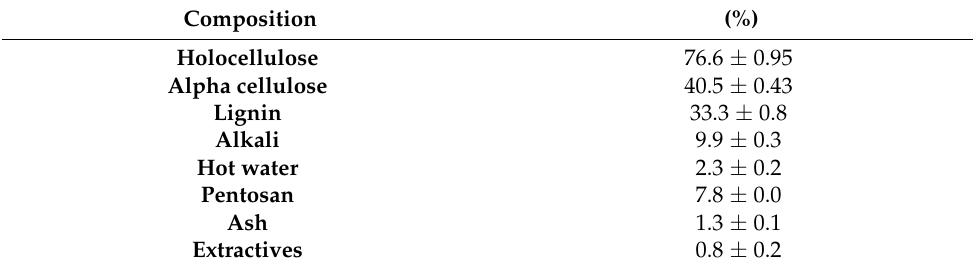
Table 1. Chemical compositions of Macaranga gigantea.